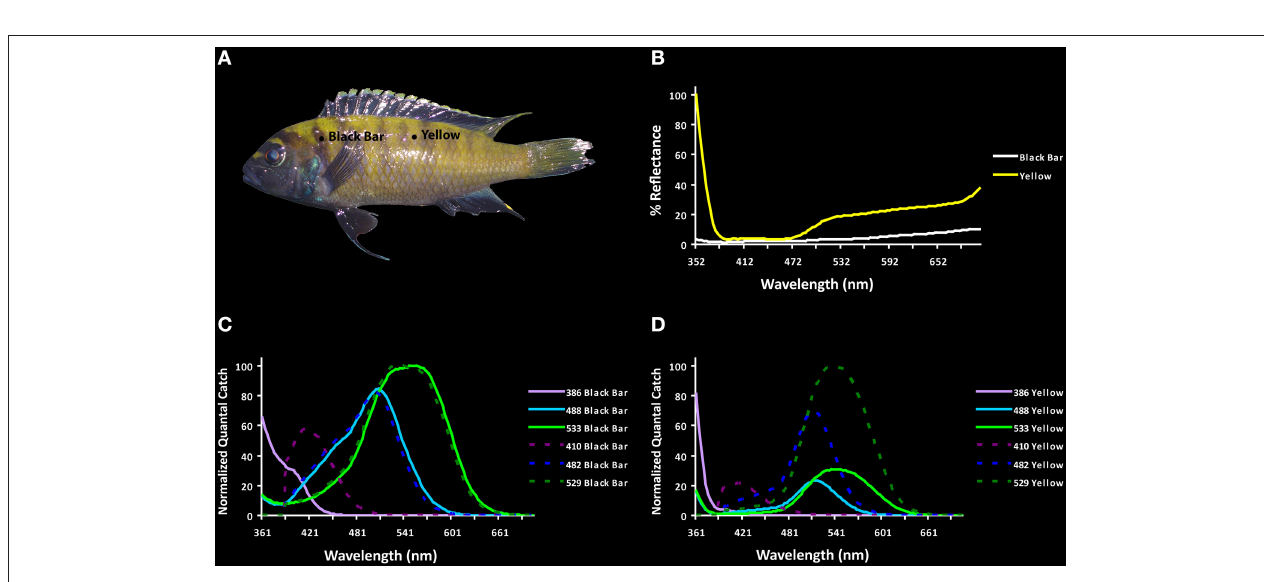
FIGURE 6 | Metriaclima zebra . Each figure in Figures 6–11 is arranged in the same fashion. There are four panels in each figure: (A) is a photograph of the fish under full-spectrum lighting (including UV illumination), indicating two points at which reflectances were measured; (B) illustrates the reflected wavelengths at the points indicated in (A) ; (C,D) are comparisons of the quantal catches of the reflectances by the photoreceptors found in two different classes of Malawi cichlid retinae: UV sensitive (solid lines) and non-UV sensitive (dashed lines). Photopigment sensitivities were taken from Hofmann et al. (2009).